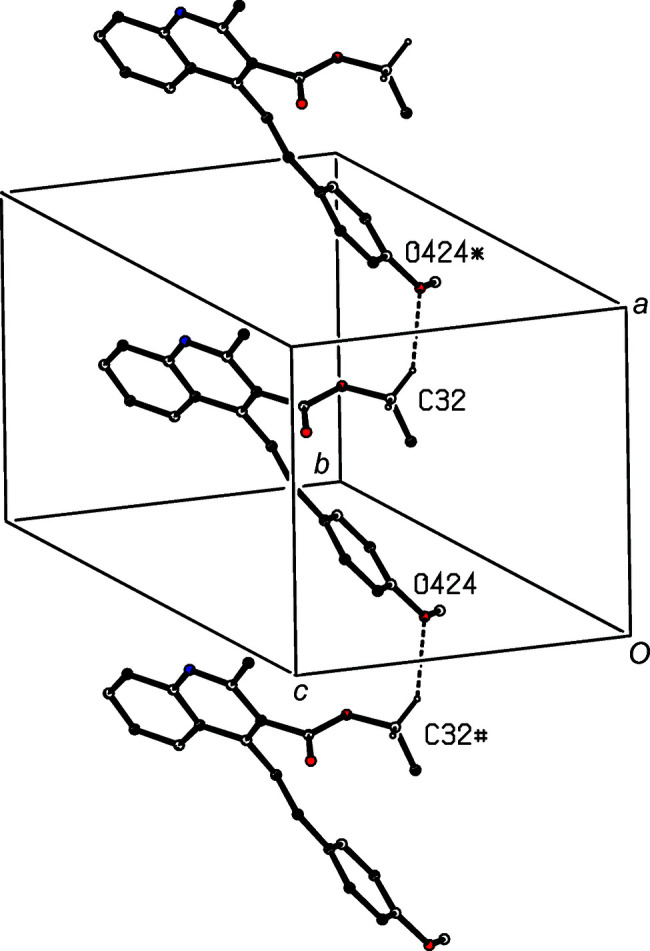
Part of the crystal structure of com­pound (IV), showing the formation of a C(13) chain running parallel to the [100] direction. Hydrogen bonds are drawn as dashed lines and, for the sake of clarity, H atoms bonded to those C atoms which are not involved in the motif shown have been omitted. Atoms marked with an asterisk (*) or a hash (#) are at the symmetry positions (x + 1, y, z) and (x − 1, y, z), respectively.